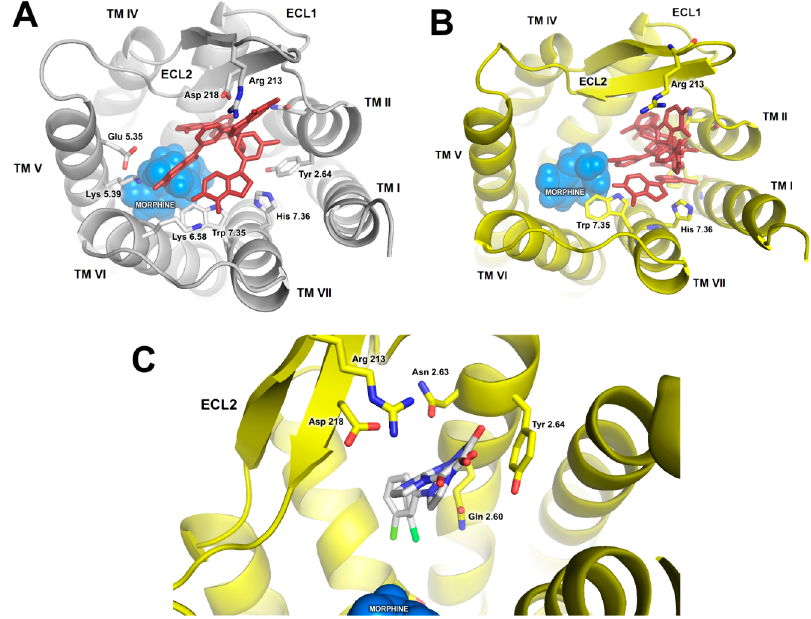
Figure 4. Possible binding modes of compound 1 in MOR. ( A ) Representative poses of the most abundant docking clusters used for short, 50 ns MD simulations. ( B ) Superposition of final ligand poses after short MD simulations. ( C ) In several simulations, compound 1 consistently drifted to similar poses, with phenyl moiety immersed in the aromatic pocket below the extracellular loop 2 (ECL2), and a dione part interacting with polar residues from the loop.